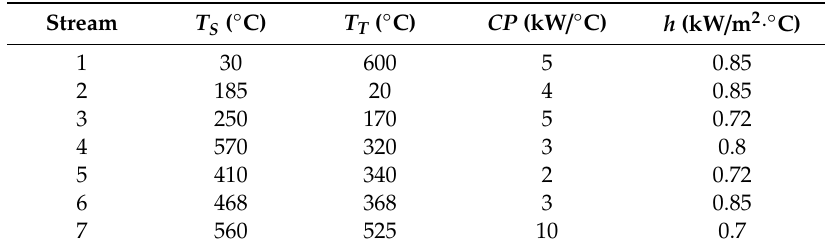
Table 5. Data pertaining to the existing HEN in the case